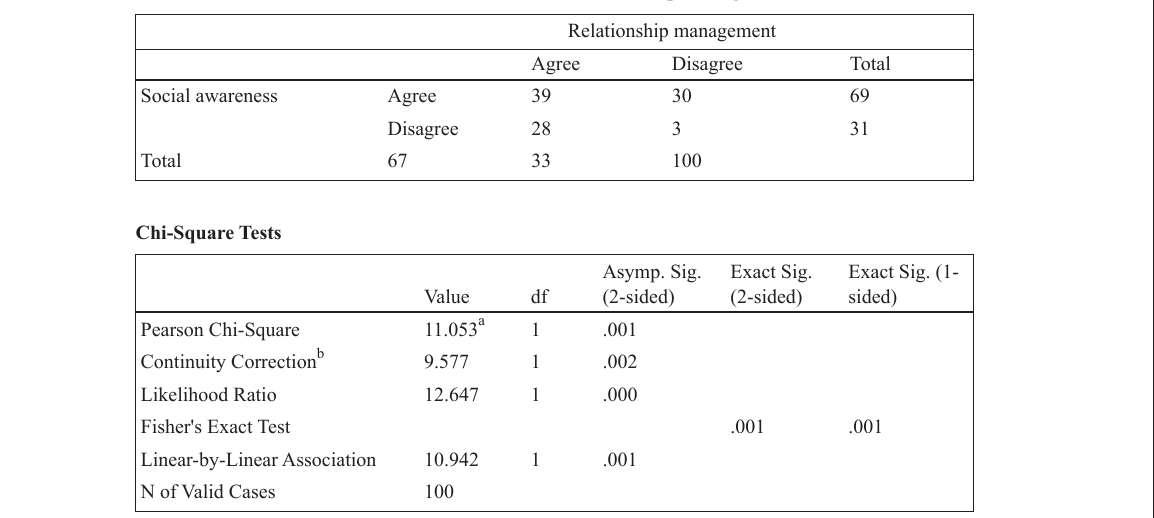
Table 5 Association between Social awareness and Relationship management attributes